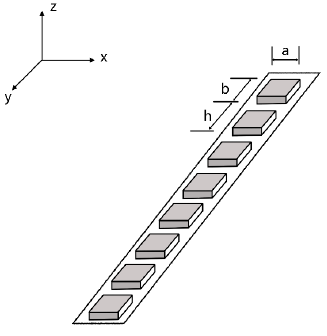
Figure 2. Amplitude distribution of first order resonant mode of vibration film.